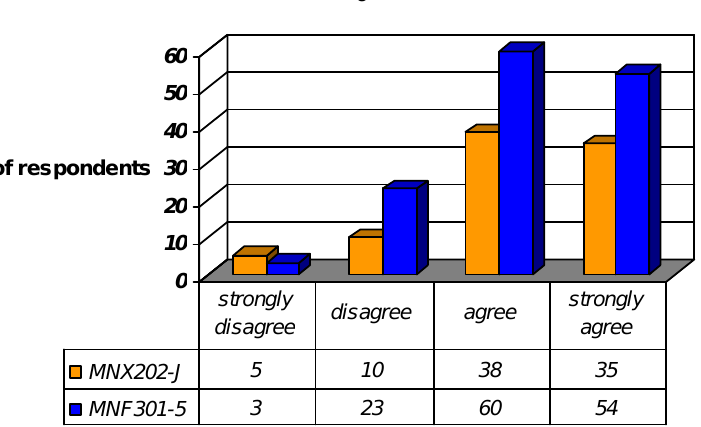
Chart A4: Master The Learning